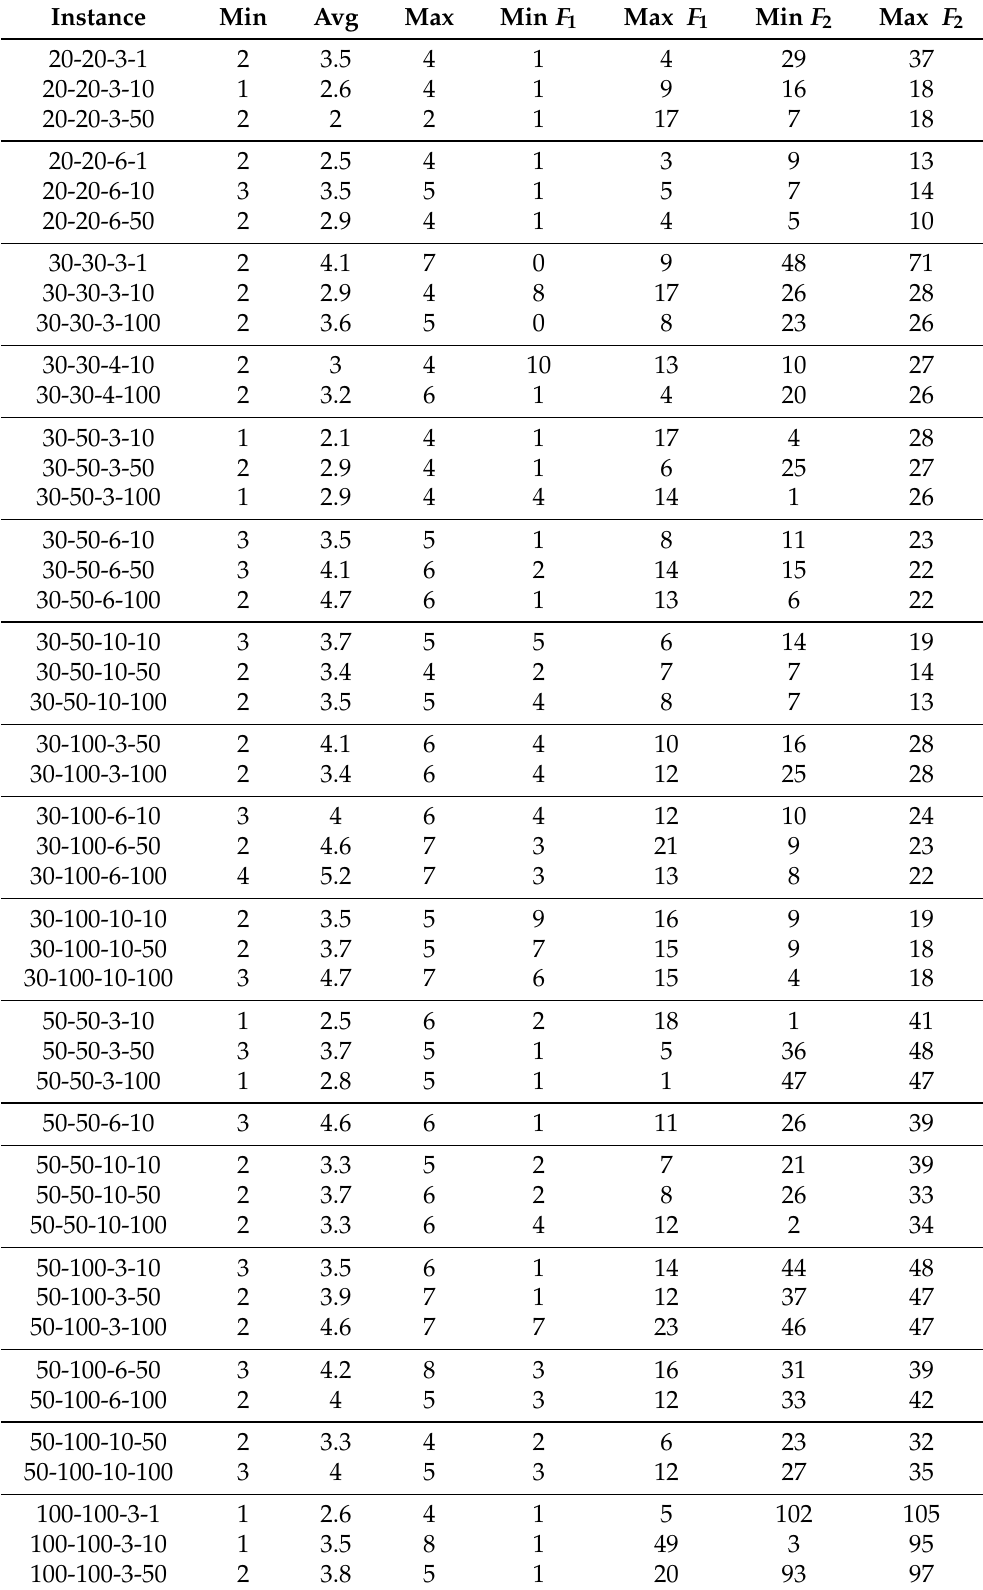
Table 2. Summary of the solutions obtained by the